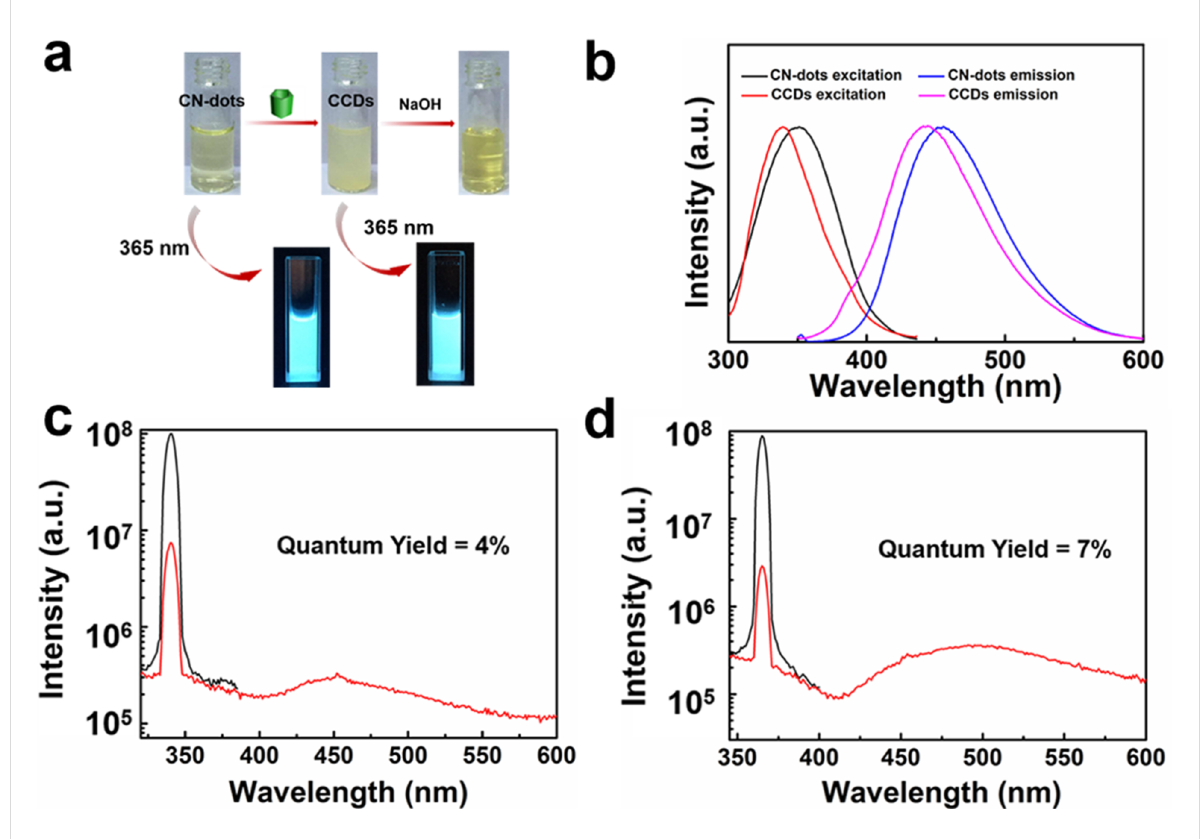
Figure 2: a) Photographs of CN-dots and CCDs in aqueous media in natural light, and under excitation with a UV lamp (365 nm). b) Emission (blue line) and excitation (black line) spectra of the CN-dots in water, and emission (pink line) and excitation (red line) spectra of the CCDs in water. Quan- tum yields of c) CCDs and d) CN-dots. Experimental conditions: Slit widths: Ex. 5 nm, Em. 5